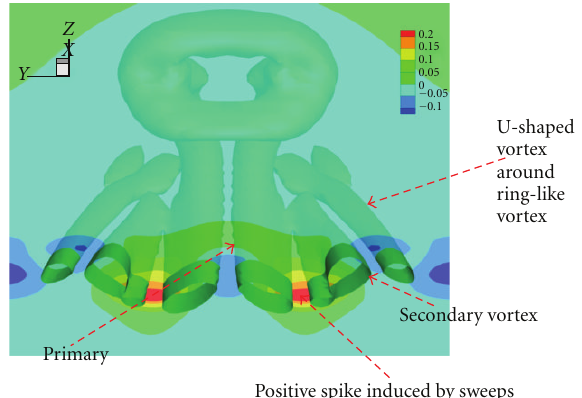
Figure 19: U-shaped vortex with streamwise velocity perturbation contour.